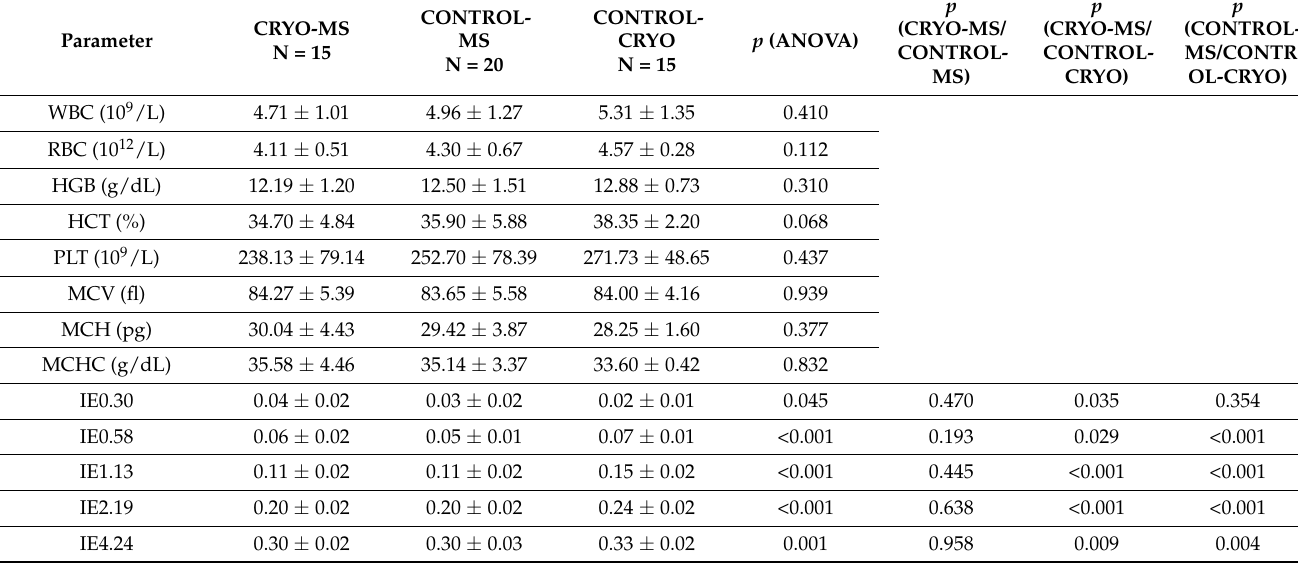
Table 3. ANOVA results: final parameters (after WBC) and